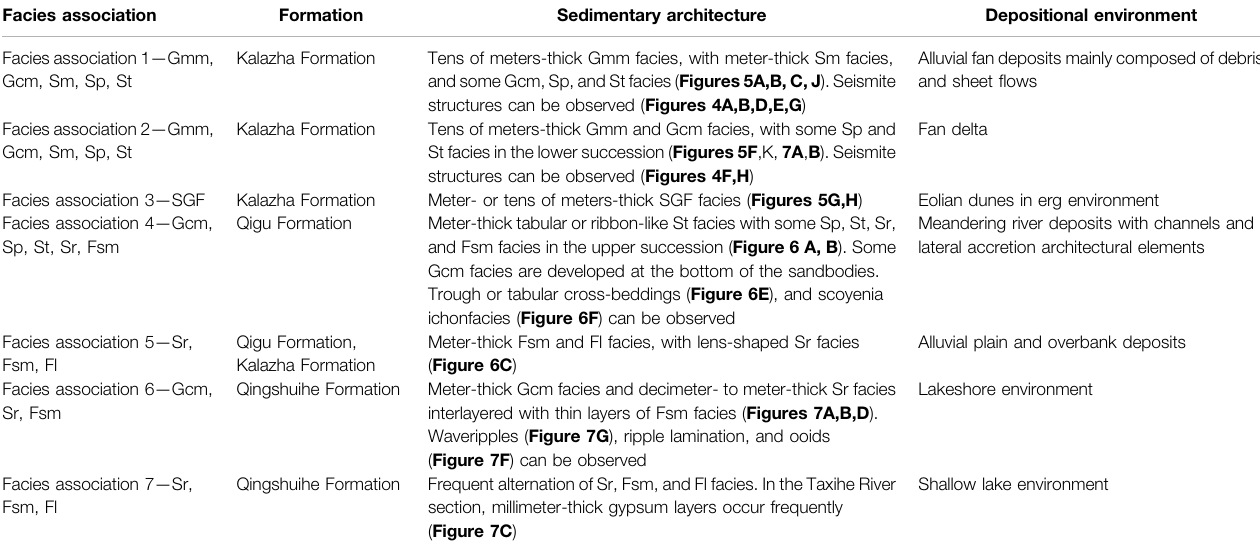
TABLE 2 | Facies associations and depositional environments in the late Mesozoic Southern Junggar